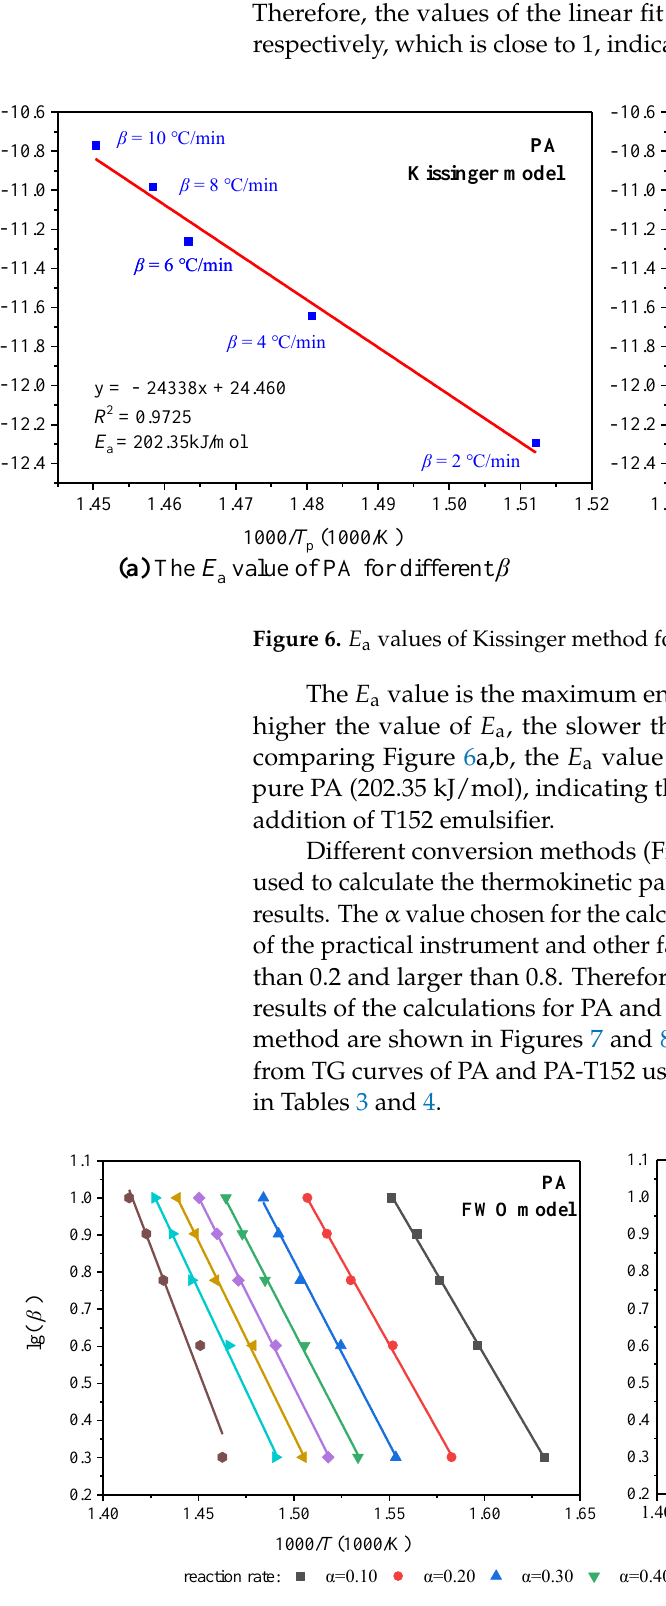
Figure 7. Calculation of E a from TG curves for PA and PA-T152 using FWO model.